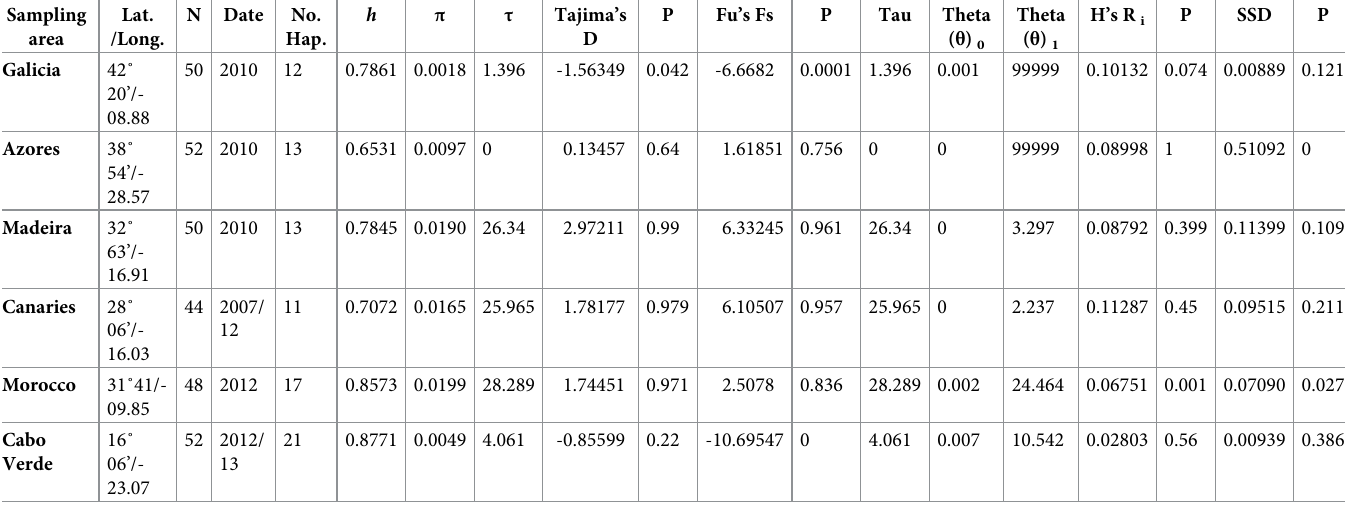
Table 1. Locations and summary statistics for Octopus vulgaris samples, including estimates of haplotype ( h ) and nucleotide ( π ) diversity, mismatch distribution parameters, neutrality, and demographic expansion test based on mitochondrial control region. Sampling